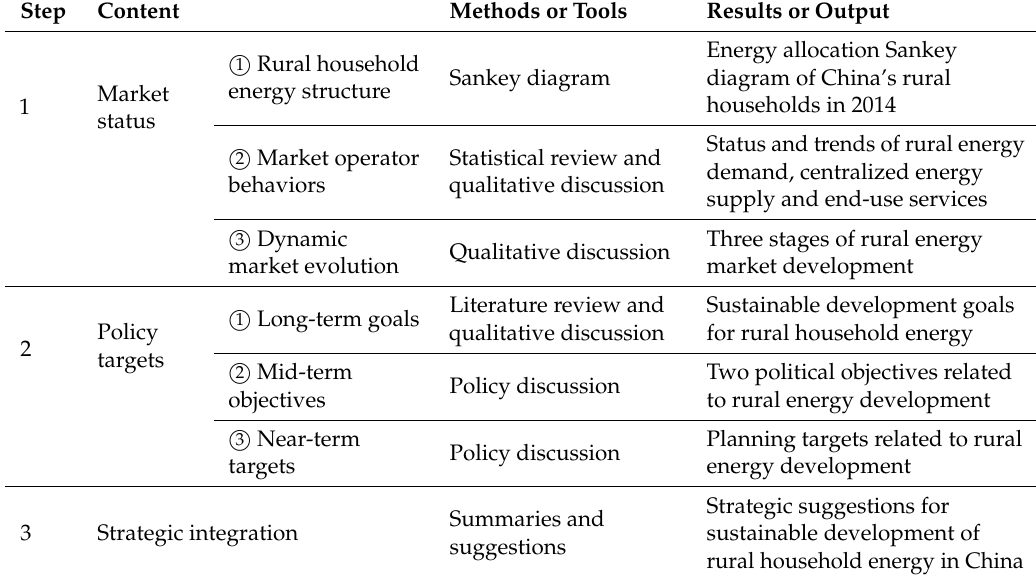
Table 2. Main content and methods of the three steps in the I-SDOP analysis.